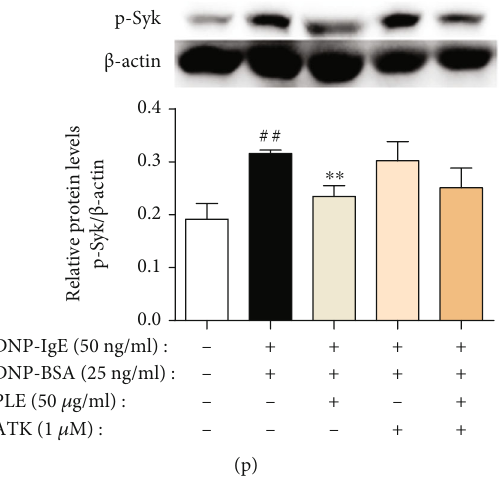
Figure 6: PLE attenuated allergic in fl ammation by targeting Syk in DNP-IgE/BSA-induced RBL-2H3 cell in vitro . (a) (A) Images (magni fi cation, × 200) of Syk expression and (B) their relative fl uorescence intensities determined by IF staining ( n = 3 ). (b) The expression of Syk cotreating with PLE and BAY61-3606 detected by WB ( n = 5 ). (c) (A) Images of (magni fi cation, × 200) p-Syk expression and (B) their relative fl uorescence intensities determined by IF staining ( n = 3 ). (d) The expression of p-Syk cotreating with PLE and BAY61-3606 detected by WB ( n = 5 ). (e – j) The expression of PKC, p-PKC, p65, p-p65, cPLA BAY61-3606 detected by WB ( n = 5 ). (k – p) The expression of Syk and p-Syk cotreating with PLE and Rottlerin, BAY11-7082, and ATK detected by WB ( n = 5 ). ## P < 0 : 01 vs. the control group; ∗ P < 0 : 05 and ∗∗ P < 0 : 01 vs. the model